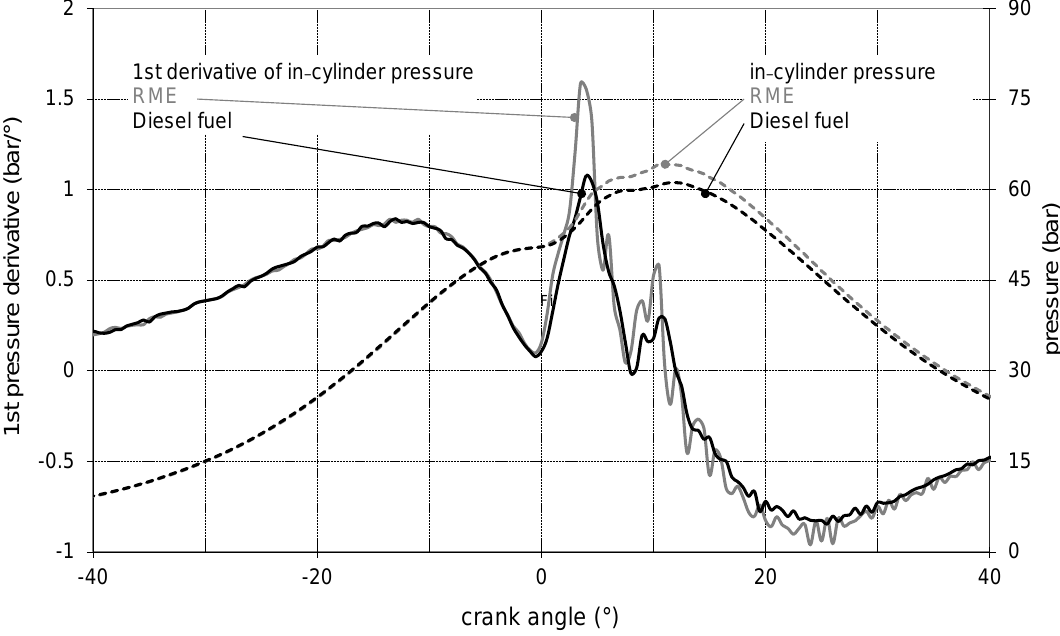
Figure 15. RME and diesel fuel in-cylinder pressures and rate of pressure rise at 2000 rpm and at full load.